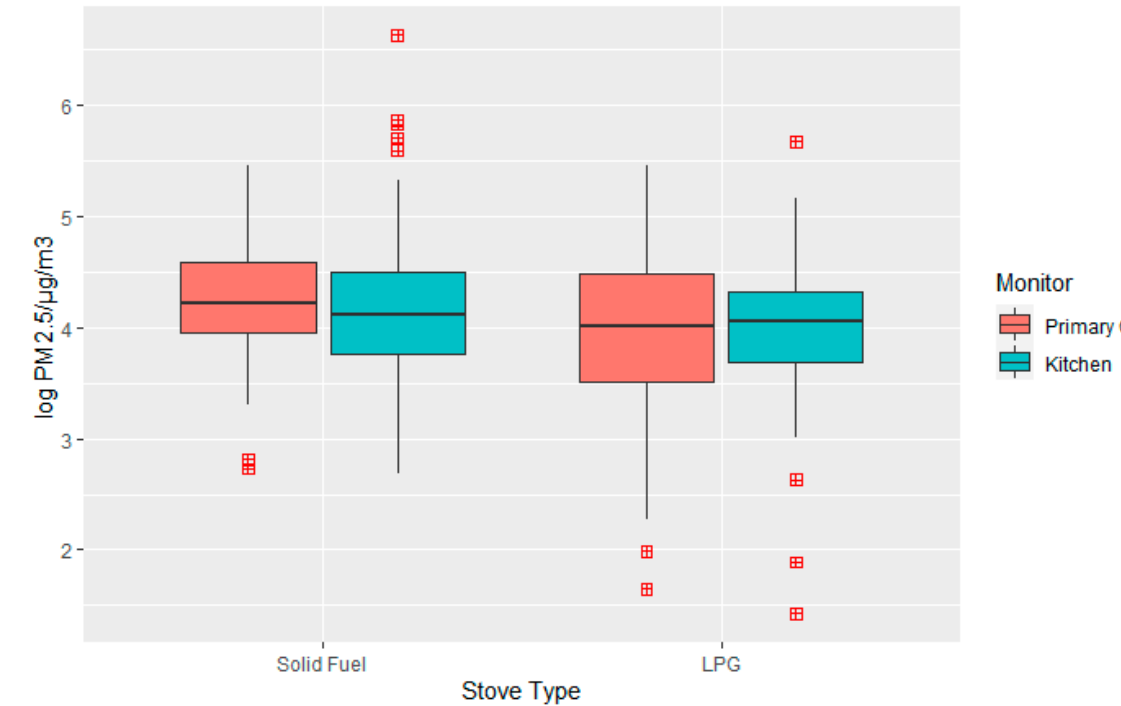
Figure 1. PM 2.5 exposure ( μ g/m 3 ) by fuel type and monitoring type. Figure 1. PM µ g/m 3 ) by fuel type and monitoring type. 2.5 exposure (